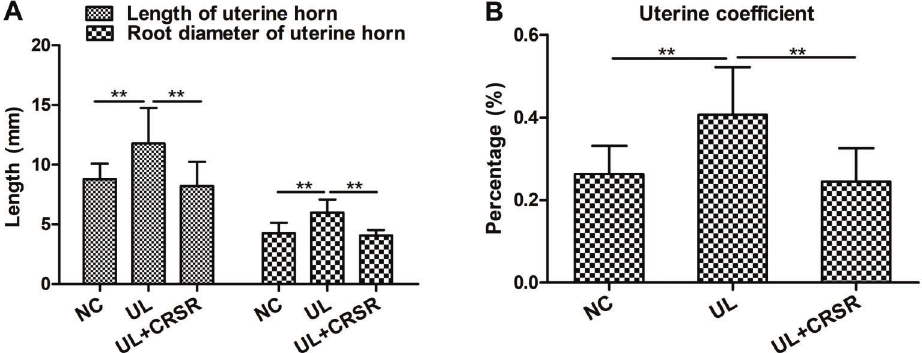
Figure 1. Effects of Curcumae rhizoma-Sparganii rhizoma (CRSR) treatment on the length of the uterine horn, the root diameter of the uterine horn ( A ), and the uterine coef fi cient ( B ). Data are reported as means ± SD. NC: normal control, n=10; UL: uterine leiomyomas, n=8; UL + CRSR: treatment group, n=10. **P o 0.01 compared with the UL model (ANOVA).